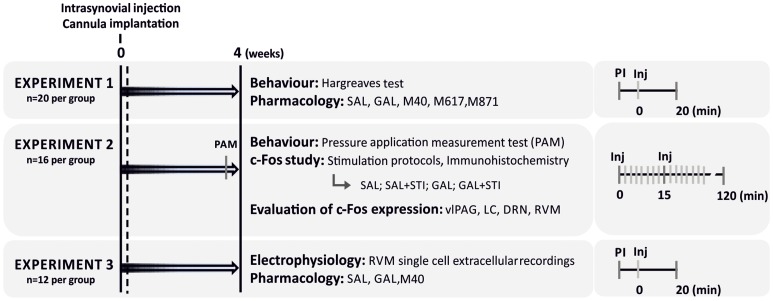
Schematic representation of the experimental design.In all experiments, animals were divided in two groups, control (SHAM) when injected with saline and arthritic (ARTH) when injected with a mixture of kaolin and carrageenan in the synovial capsule of the right knee joint. Three days after the intrasynovial injection, arthritis was confirmed by performing five consecutive movements of flexion/extension of the knee (dashed line). Animals in the ARTH group developed a clear swelling of the treated knee joint and all gave a vocalization response during a minor extension and flexion of the affected limb by the experimenter. SHAM animals displayed no obvious swelling of the knee joint and did not vocalize when the limb was flexed. Four weeks after the induction of monoarthritis animals were tested in three independent experiments. In experiment 1, the Hargreaves test was used to study the effect of exogenous galanin (GAL), a non-specific GAL receptor antagonist (M40), a specific GAL receptor-1 agonist (M617) and a specific GAL receptor-2 antagonist (M871) in the dorsomedial nucleus of the hypothalamus (DMH) upon paw-withdrawal latency (PWL) (n = 20 per experimental group). In each animal, the development of arthritis was confirmed again 1 h prior to each behavioural session by performing five consecutive movements of flexion/extension of the knee. During the experimental sessions, PWL was assessed before and 20 min after the administration of the drugs to the DMH. In experiment 2, two days prior the c-Fos study, the pressure application measurement (PAM) test was performed to confirm the arthritic state of the animals. c-Fos expression was evaluated in SHAM and ARTH animals after exogenous GAL or saline (SAL) administration in the DMH, peripheral noxious mechanical stimulation and the simultaneous application of noxious mechanical stimulation after the microinjection of exogenous GAL in the DMH (n = 16 per experimental group). Peripheral stimulation was applied each 2 minutes during 2 hours and two drug injections were made in the DMH, one at the beginning and another 15 minutes after the beginning of peripheral stimulation. Neurones expressing c-Fos were quantified bilaterally in the ventrolateral periaqueductal grey matter (vlPAG), locus coeruleus (LC), dorsal raphe nucleus (DRN) and rostral ventromedial medulla (RVM). In experiment 3, RVM neurones were recorded before and after the administration of exogenous GAL and M40 in the DMH. The assessment of neuronal activity includes a preliminary evaluation of spontaneous and noxious-evoked activity followed by the recording of these parameters 20 min after drug administration to the DMH (n = 12 animals per experimental group). PI – Pre-injection; Inj – Injection; SAL - saline microinjection in the dorsomedial nucleus of the hypothalamus; GAL - galanin microinjection in the dorsomedial nucleus of the hypothalamus; SAL+STI – saline microinjection in the dorsomedial nucleus of the hypothalamus and extension of right limb; GAL+STI – galanin microinjection in the dorsomedial nucleus of the hypothalamus and extension of right limb.